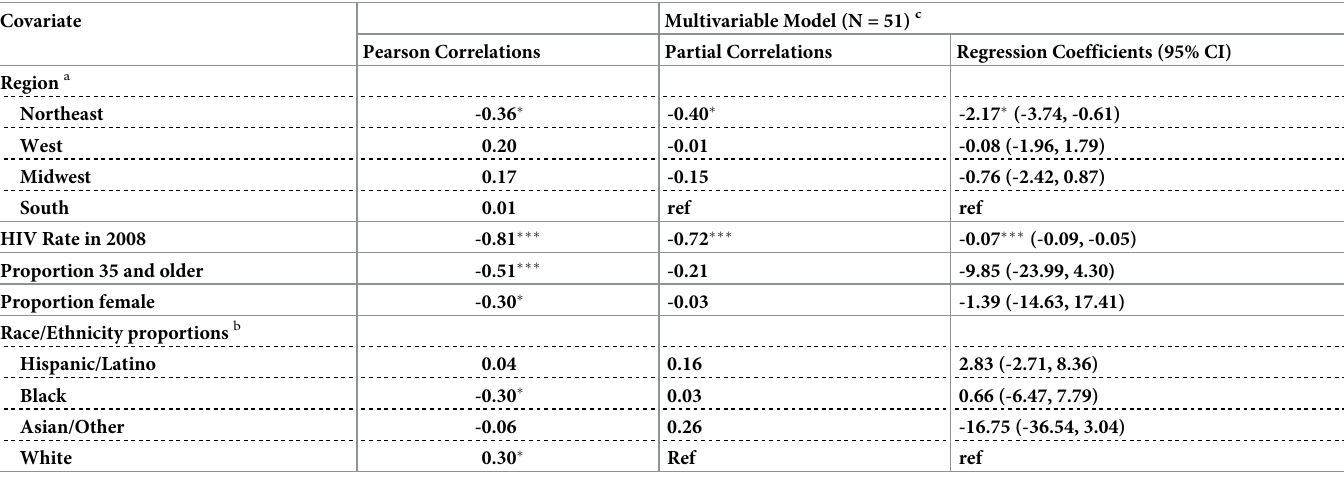
Table 3. Multivariate regression model to assess the association of hotspot characteristics with 10-year AAPC trends.